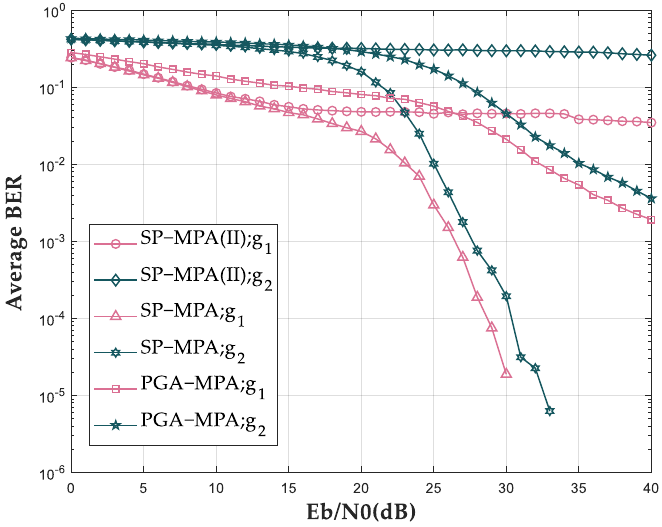
Figure 16. Average BER curves of SP − MPA in MIMO system.